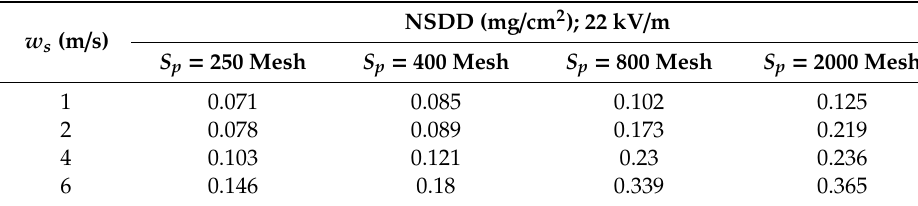
Table 4. NSDD under electrical stress of 22 kV / m.